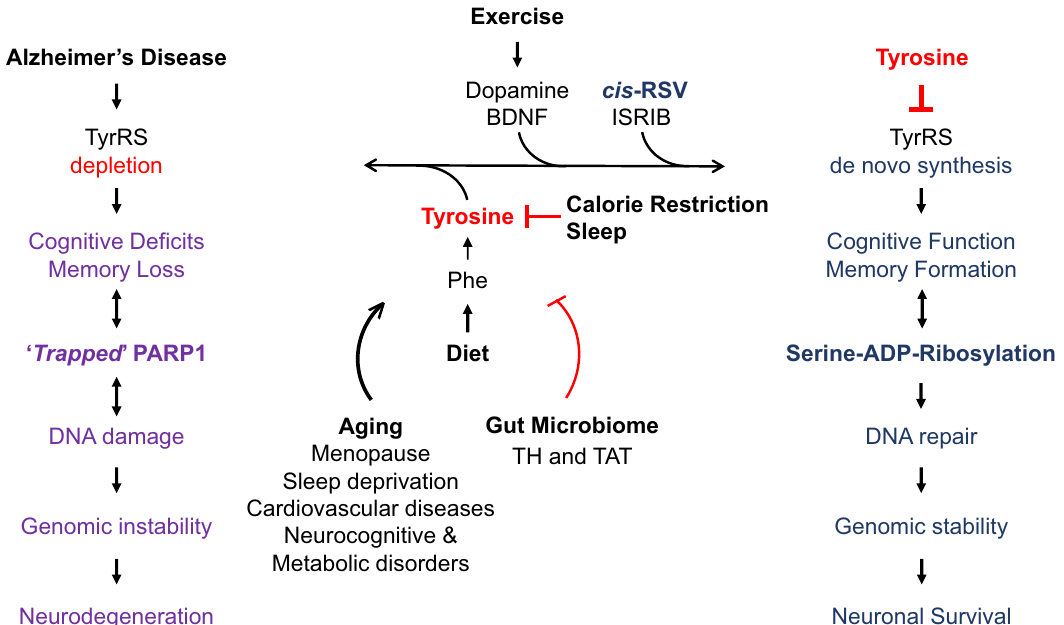
Fig. 10 Potential mechanism of tyrosine-mediated induction of age-associated neurocognitive disorders, DNA damage, genomic instability, and neurodegeneration. Age-associated increase in serum tyrosine levels may decrease the de novo synthesis of neuronal TyrRS. Serum tyrosine levels may be modulated by changes in lifestyle like diet, exercise and sleep or by metabolic disorders. Exercise that increases BDNF and dopamine levels may increase the brain protein levels of TyrRS and histone serine-ADP-ribosylation. Similarly, TyrRS levels may be increased using cis-RSV and low concentration